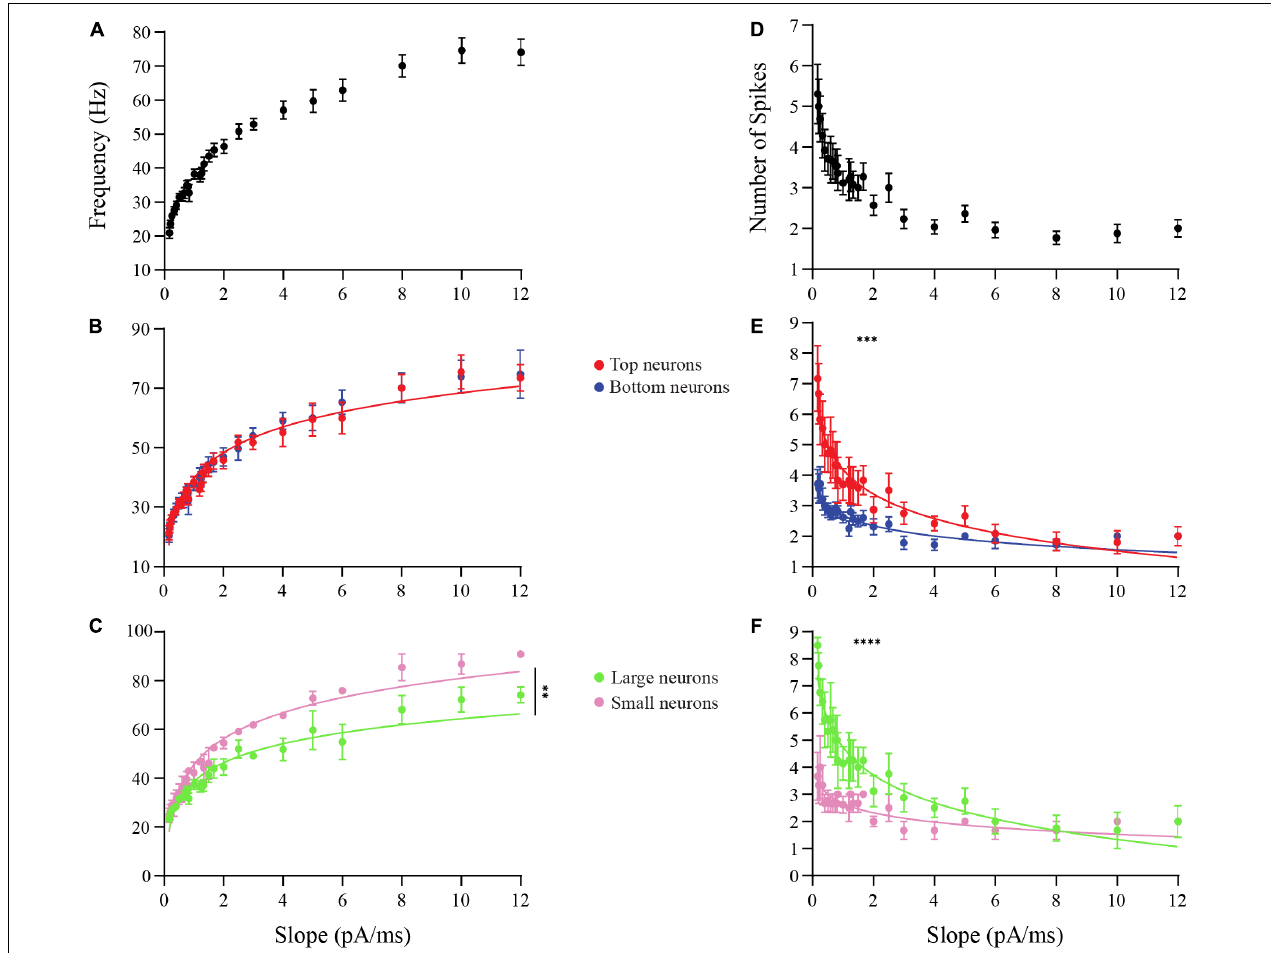
FIGURE 7 | Analysis of the effects of ramp slopes on the spike frequencies and the number of spikes of OB DA neurons. (A) The frequency responses (in Hz) of neurons ( n = 13) that spiked more than once per ramp stimulus increase with increasing ramp slopes. (B) After transforming these power functions into log-log plots (see section “Materials and Methods”), there was no difference ( n = 13, p = 0.3544) in the increasing spike frequencies with increasing ramp slopes between Top and Bottom DA neurons. (C) The increasing spike frequencies with increasing ramp slopes was significantly higher ( n = 7, p < 0.0043**) in Small than Large neurons. (D) Number of spikes produced with increasing ramp slopes of neurons ( n = 13) drops dramatically, particularly between 0 and 2 pA/ms ramps. (E) Top DA neurons produced a significantly greater decrease in spikes across increasing ramp slopes than did Bottom neurons ( n = 13, p = 0.0009***). (F) There was an even greater decrease in spikes across increasing ramp slopes in Large compared to Small DA neurons ( n = 7, p <